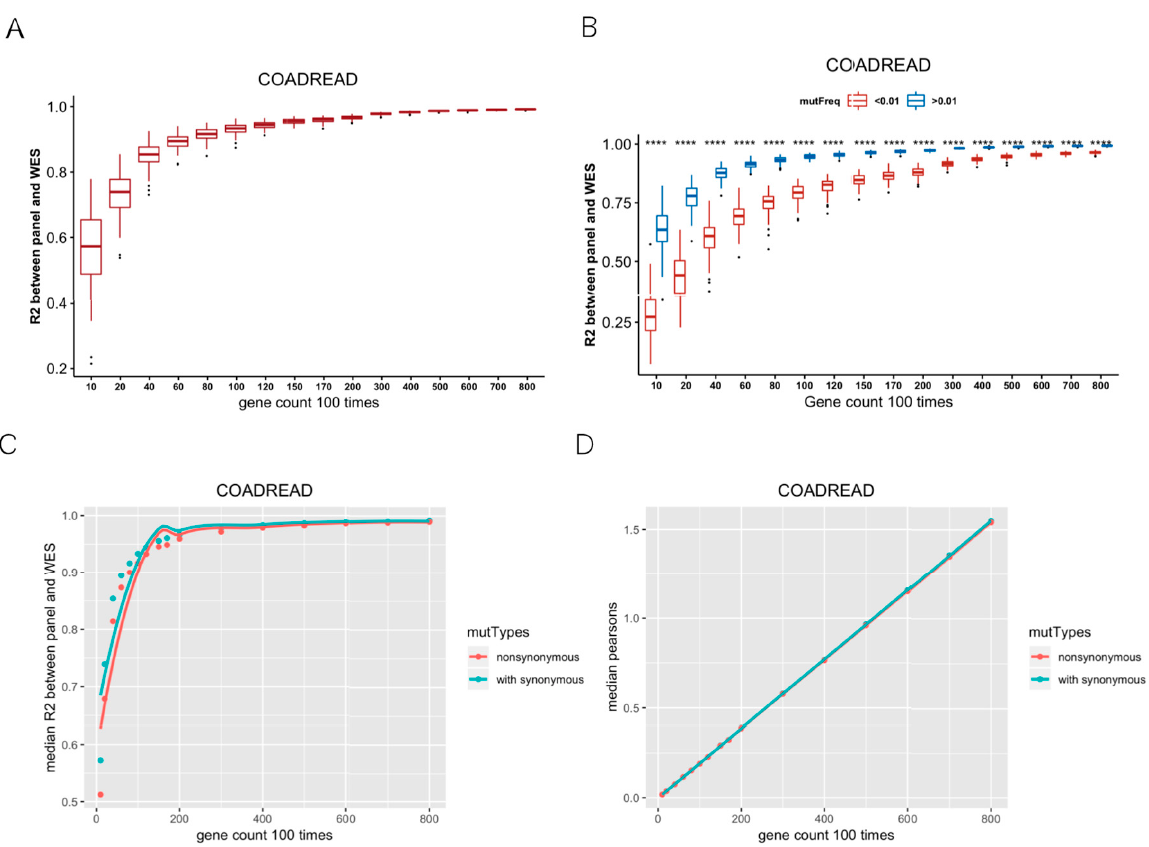
Figure 1. Establishment of screening criteria for TMB gene panel collection. ( A ) Coefficient of determination (R 2 ) between random gene panel TMB from mutated gene and WES TMB. With the increase in random gene in gene panel, R 2 had a tendency of becoming flat. ( B ) R 2 between random gene panel TMB from high-mutation group (mutation frequency > 0.01) and WES TMB (blue boxplot), low-mutation group (mutation frequency < 0.01), and WES TMB (red boxplot). R 2 values were significantly different (‘****’ means Wilcox test p value < 0.0001) between these two groups. ( C ) Median R 2 between synonymous mutations included and excluded for gene panel TMB and WES TMB. ( D ) Median gene length of synonymous mutations included and excluded from random gene panel.